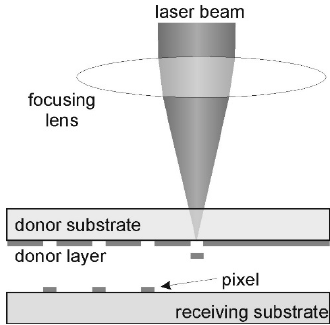
Figure 1. Scheme with the main elements in a typical Laser-induced forward transfer (LIFT) setup for laser printing.